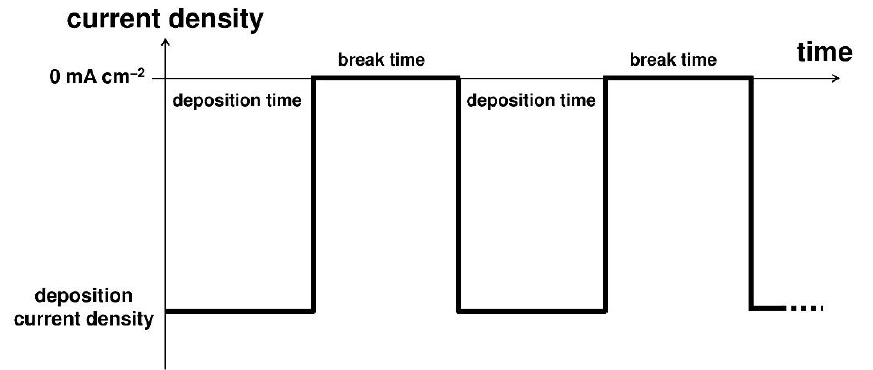
Figure 10. Sketch of the pulsed current.